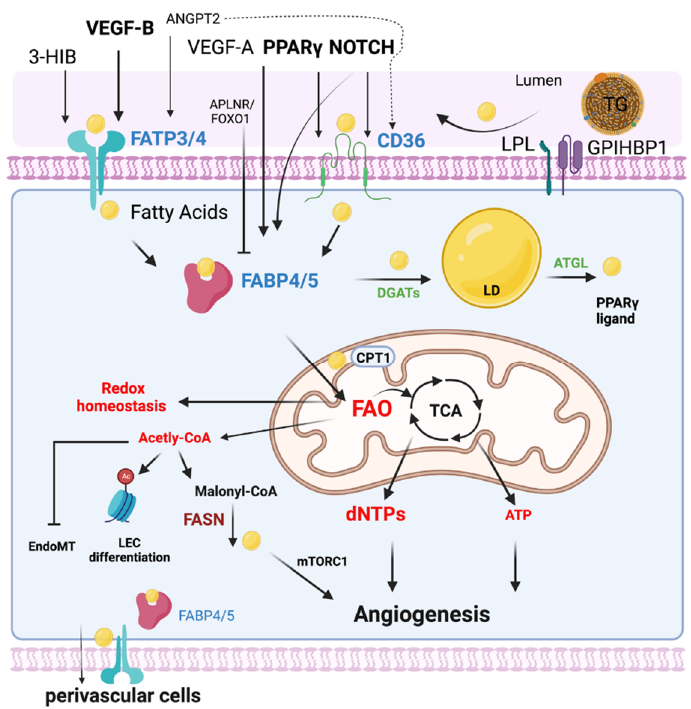
Figure 1. EC FA metabolism. Fatty acids (FAs) are transported in the form of triglyceride (TG)-rich lipoproteins, which are released by lipoprotein lipase (LPL) and GPIHBP1 in the luminal side of ECs. Free FAs are transported across EC membranes by fatty acid transporter protein 3 and 4 (FATP3/4) and CD36. Intracellular FAs transportation is mediated by FABP3 and FABP4. Intracellular FAs could be synthesized by FA synthase (FASN) from Malonyl-CoA and affect mTORC1 activity for angiogenesis. DAGTs and ATGL are key enzymes regulating lipid droplet (LD) storage and lipolysis. FAs are transported into mitochondria via CPT1 for FA oxidation (FAO). Quiescent ECs utilize FAO to maintain redox homeostasis. FAO is required for the generation of dNTPs for EC spouting and angiogenesis. In certain conditions such as glucose depletion, FAO produces ATP in ECs. FAO also produces acetyl-CoA for epigenetic regulation, inhibiting EndoMT. The efflux of FAs to the perivascular cells could be mediated by FABP4/5 and FATP3/4. Many key endothelial signaling including VEGF, NOTCH, and PPAR γ control EC FA transport via regulating FATPs, FABPs, and CD36.